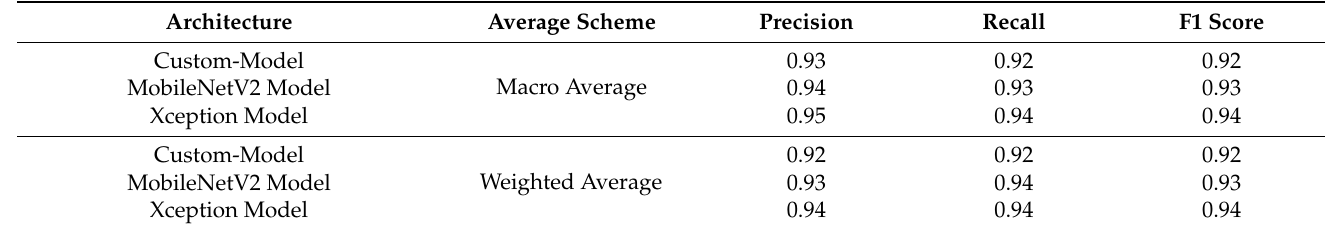
Table 2. Macro and weighted averages of different